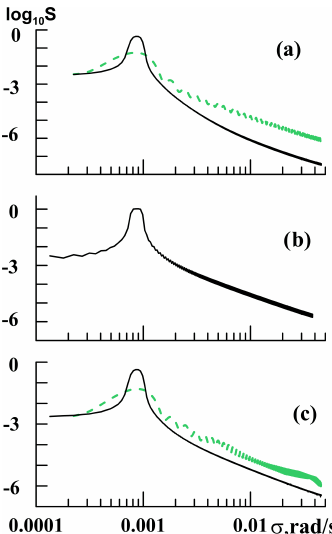
Figure 1. Spectral density (in relative units) of the surface wave source (Eq. 5) having period of 2h for 20h running time intervals centered at model times t ≈ 20h (a) , t ≈ 70h (b) and t ≈ 120h (c) , which correspond to the wave forcing activation, activated state and deactivation. Solid and dashed lines correspond to the steep and sharp activation and deactivation rates s a and s d in (Eq. 7).